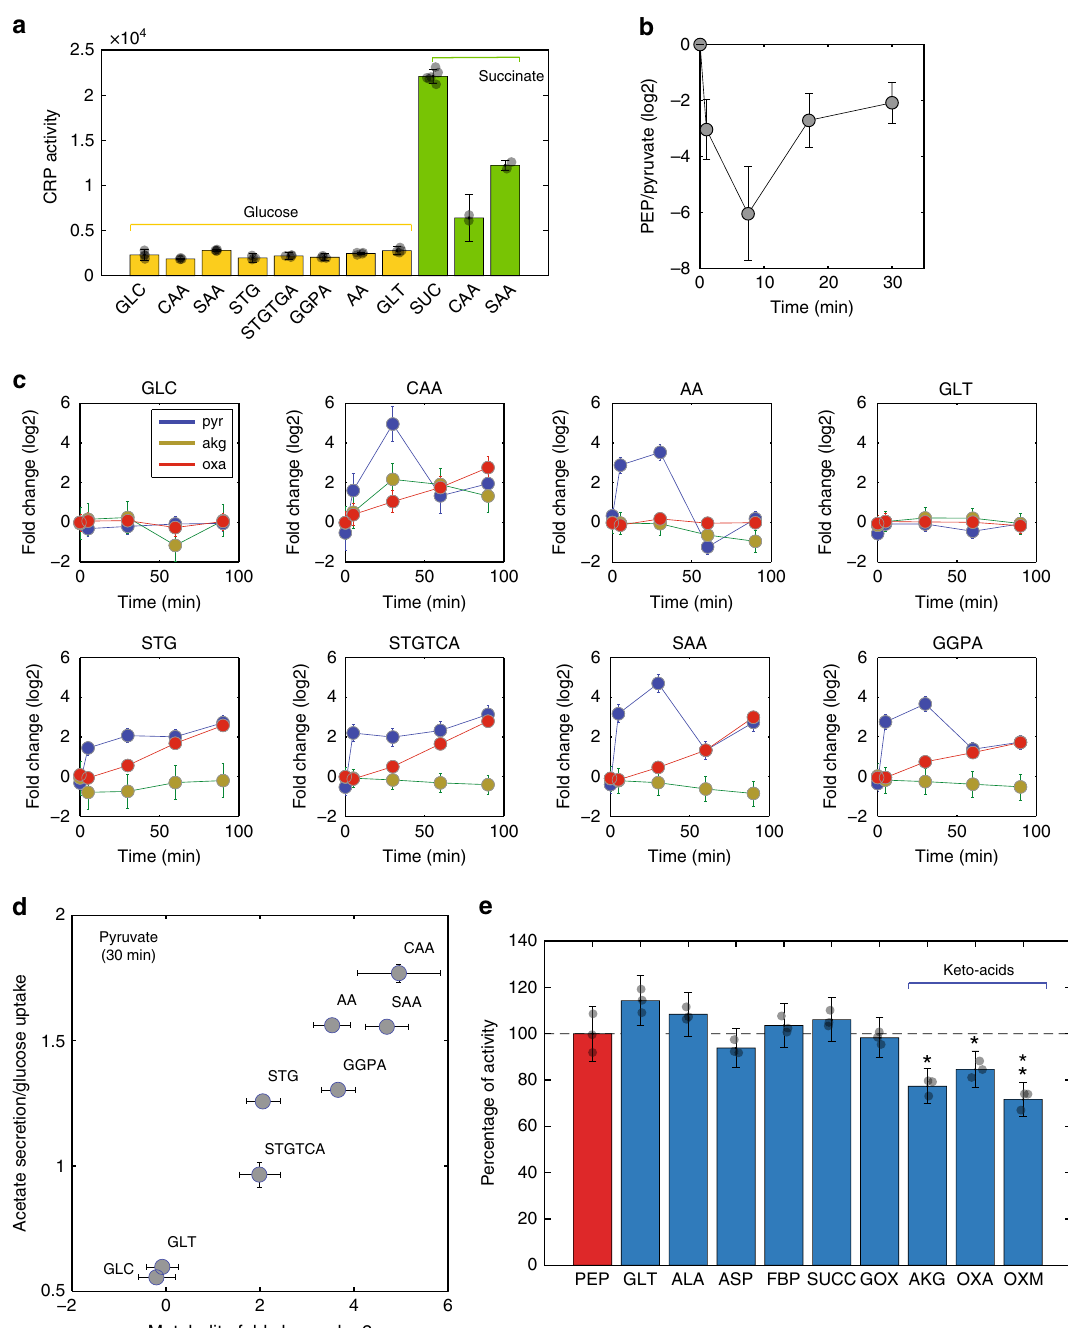
Fig. 5 Coordination of glucose and amino acids catabolism. a Mean± standard deviation of Crp activity across different nutritional environments: minimal medium with either glucose (GLC) or succinate (SUC in green, positive control), and glucose minimal media supplemented with casamino acids (CAA), synthetic amino acid mix (SAA), SAA deprived of amino acids that can be degraded into pyruvate: (i) threonine, glycine and serine (STG) or (ii) threonine, glycine, serine, tryptophan, cysteine, and alanine (STGTCA), or α -ketoglutarate: (iii) glutamate, glutamine, proline, and arginine (GGPA), or oxaloacetate: (iv) aspartate and asparagine (AA), and glucose minimal medium with 0.125 g/L of glutamate (GLT). b Dynamic changes of the ratio between phosphoenolpyruvate and pyruvate upon CAA supplementation. c Dynamic relative changes in the abundance of pyruvate (blue), oxaloacetate (red), and α -ketoglutarate (yellow) upon supplementation with the different amino acid mixtures and glucose as the main carbon source. d Relative changes in the abundance of pyruvate 30 min after amino acid addition vs. the ratio between acetate secretion and glucose consumption. e In vitro activity of PtsI in the presence of only the reactant phosphoenolpyruvate (PEP), or PEP with the addition of glutamate (GLT), alanine (ALA), aspartate (ASP), fructose bis- phosphate (FBP), succinate (SUC), glyoxylate (GOX), α -ketoglutarate (AKG), oxaloacetate (OXA), and oxamate (OXM). Bar plots report mean ± standard deviation across three